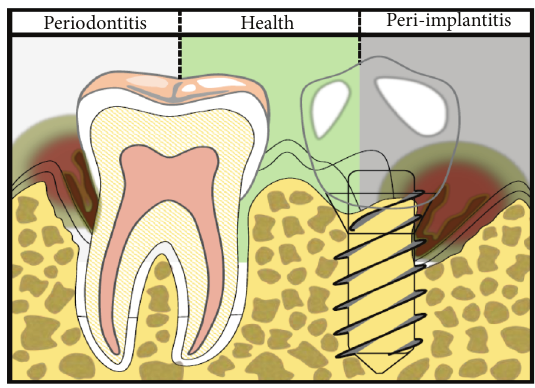
Figure 2: Periodontitis (left); peri-implant (right)